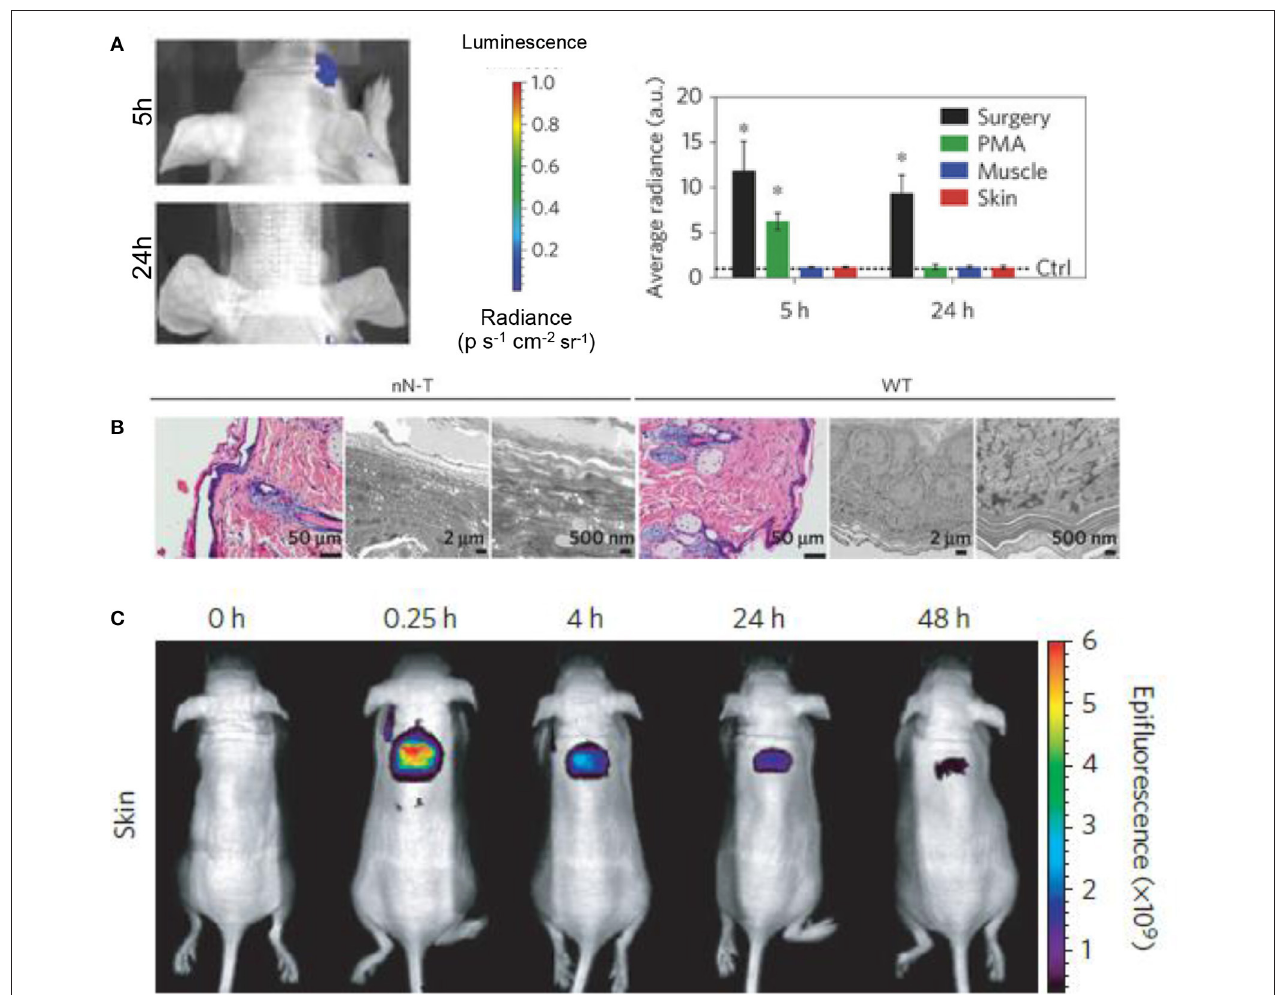
FIGURE 7 | Biomarkers and fluorescent dyes are beneficial in biomaterial risk assessment. (A) Imaging and quantification of the luminol luminescence in mice treated with silicon nanoneedles. Phorbol-12-myristate-13-acetate (PMA) treatment and surgical incisions were employed as positive controls for acute inflammation and the data was normalized to the control represented by the dashed line (* p < 0.05, n = 3). Silicon nanoneedle treatment showed no acute inflammatory response in muscle or skin at 5 and 24h. (B) H&E and transmission electron microscopy (TEM) micrographs of nanoneedle treated (nN-T) and wild-type (WT), or control, tissues show complex structure regenerated by the nanoneedle treatment. (C) Localized drug distribution in skin over 48h was shown by delivering fluorescent dyes with silicon nanoneedles. Reprinted with permission from Chiappini et al. (2015). Copyright 2015, Nature publishing